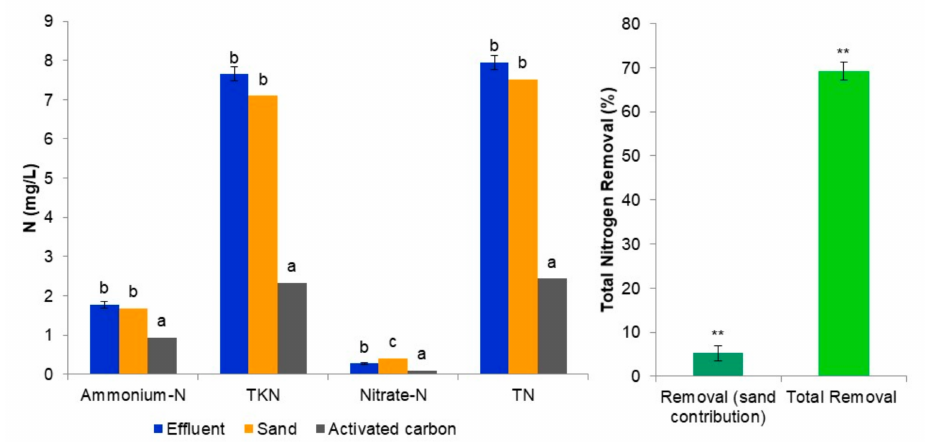
Figure 4. Changes in the concentrations of different nitrogen forms (NH 4+ -N, TKN, NO 3 − -N, total Kjeldahl nitrogen) ( left graph) and removal levels ( right graph) during processing of the biologically treated fungicide-containing effluent through the sand filter and the activated carbon adsorption column system. For each measured parameter, bars designated by the same letter are not significantly different at the 5% level. Asterisks indicate statistically significant differences at the 1% level regarding the total nitrogen (TN) removal efficiency after sand filtration and the sand filtration-activated carbon adsorption